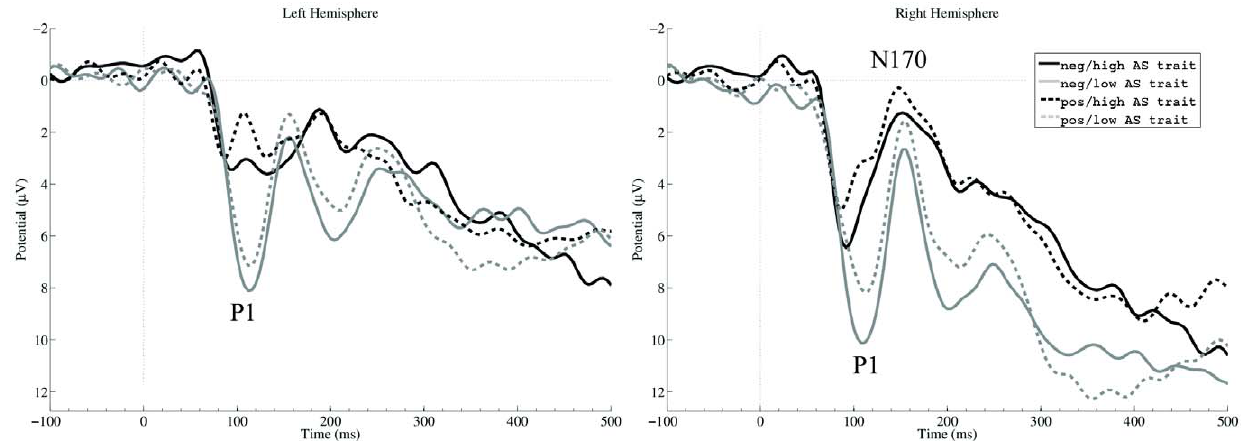
Figure 1. Grand average waveforms. Grand averages of the feedback presentation of low antisocial trait (low AS trait; grey) and high antisocial trait (high AS trait; black) individuals depicted at left (averaged mean amplitudes of L23 and L24) and right (averaged mean amplitudes of R26 and R27) electrode locations. The dotted line at time 0 indicates stimulus onset, negative is drawn upwards per convention.